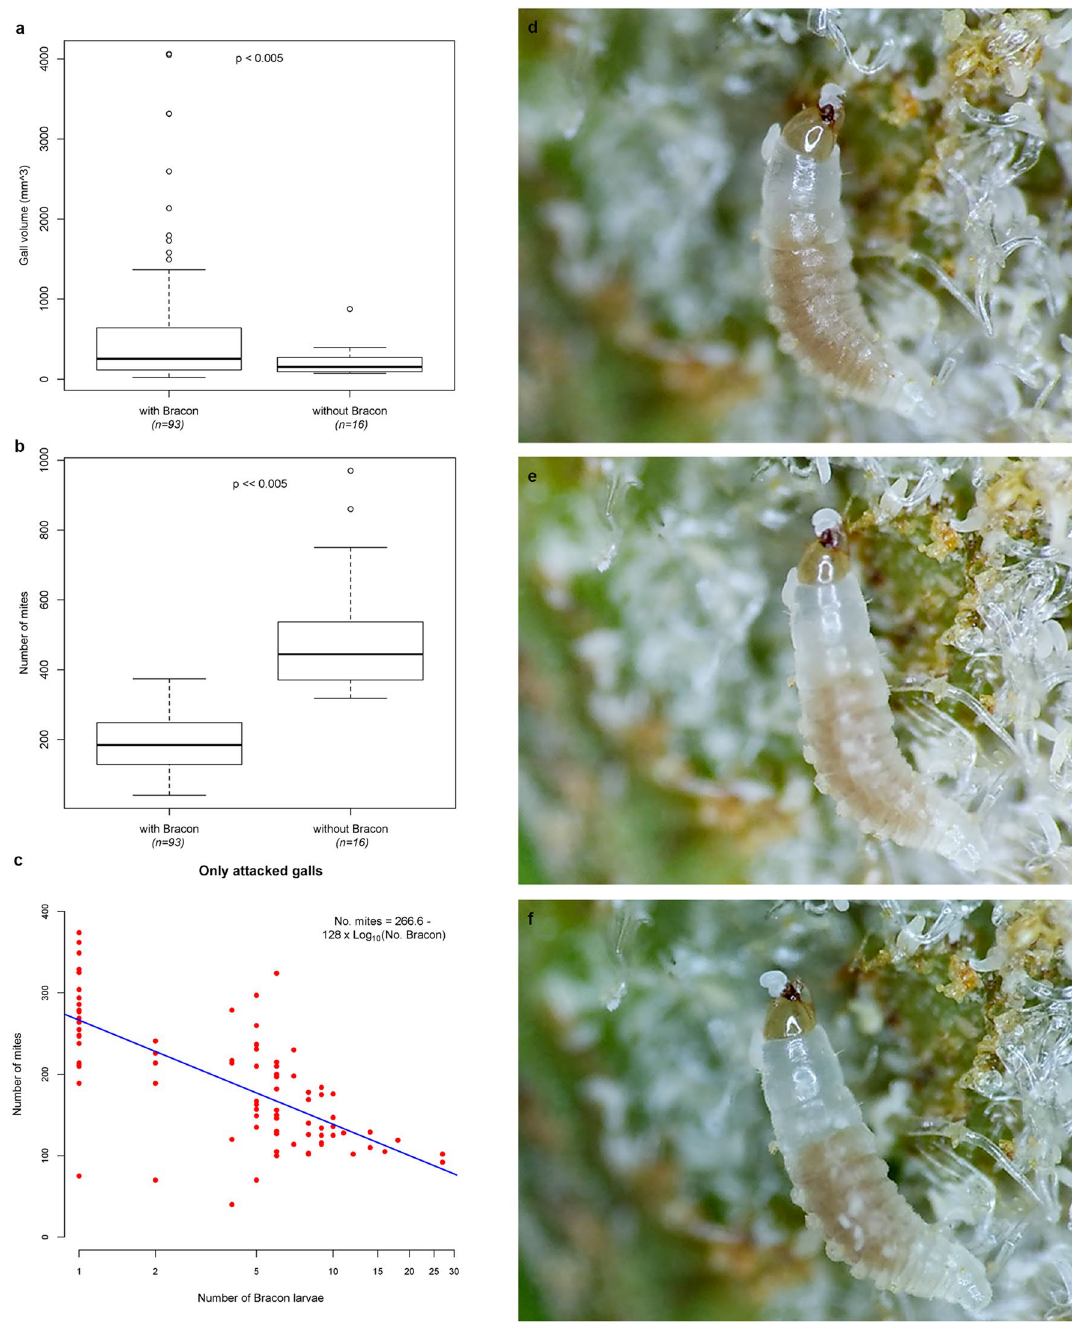
Figure 2. Predatory behaviour of Bracon predatorius Ranjith & Quicke sp. nov. (a–c ) Relationships between presence/absence and number of B. predatorius , gall size and numbers of mites (median, upper and lower quartiles, 1.5 × interquartile range and outliers): ( a ) galls without Bracon predatorius (n = 16) are significantly smaller than those with one or more Bracon predatorius (n = 93) (t = 3.7592, DF = 97.265, p-value = 0.000291), ( b ) galls without Bracon predatorius contain significantly more mites than those with (t = 6.308, DF = 15.877, p-value = 0.0001), ( c ) mite number as a function of number of Bracon predatorius larvae (only in parasitised galls) with gall volume as co-variate (n = 93, adjusted R 2 = 0.4657,F = 21.13 on 3 and 89DF, p-value = 0.0001), gall volume and interaction were non-significant. ( d–f ) Sequential images of predatory behaviour of Bracon predatorius